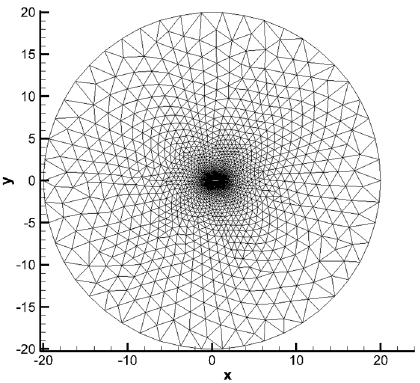
Figure 7. Initial mesh of test case 2.